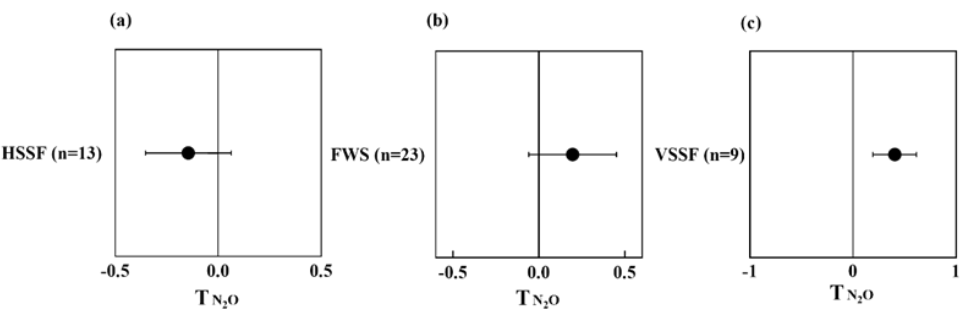
Figure 7. Effect on T index of N 2 O emission from different types of vegetated CWs, i.e., HSSF ( a ), FWS ( b ), and VSSF ( c ), compared to unvegetated CWs.